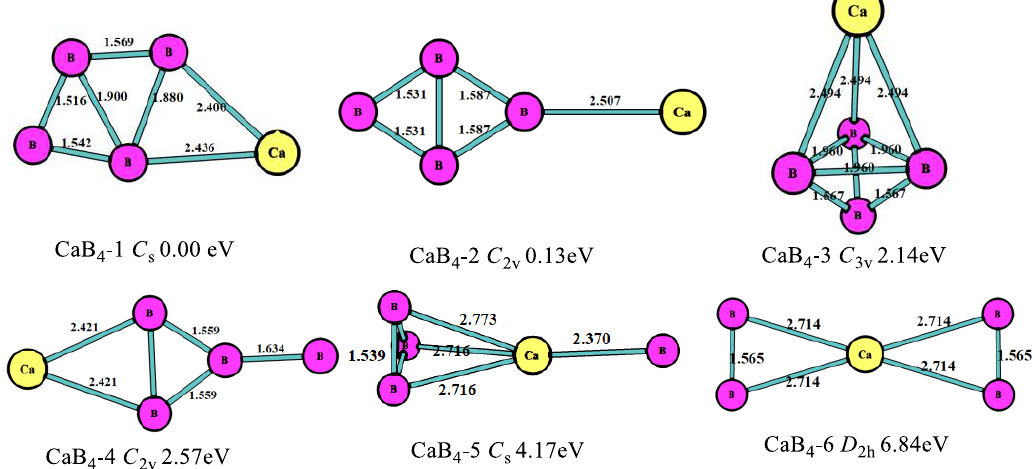
Figure 2. The geometry structures of the CaB 4 clusters obtained at MP2/6-311+G(d)//B3LYP/6-311+G(d). The bond length unit is Å .